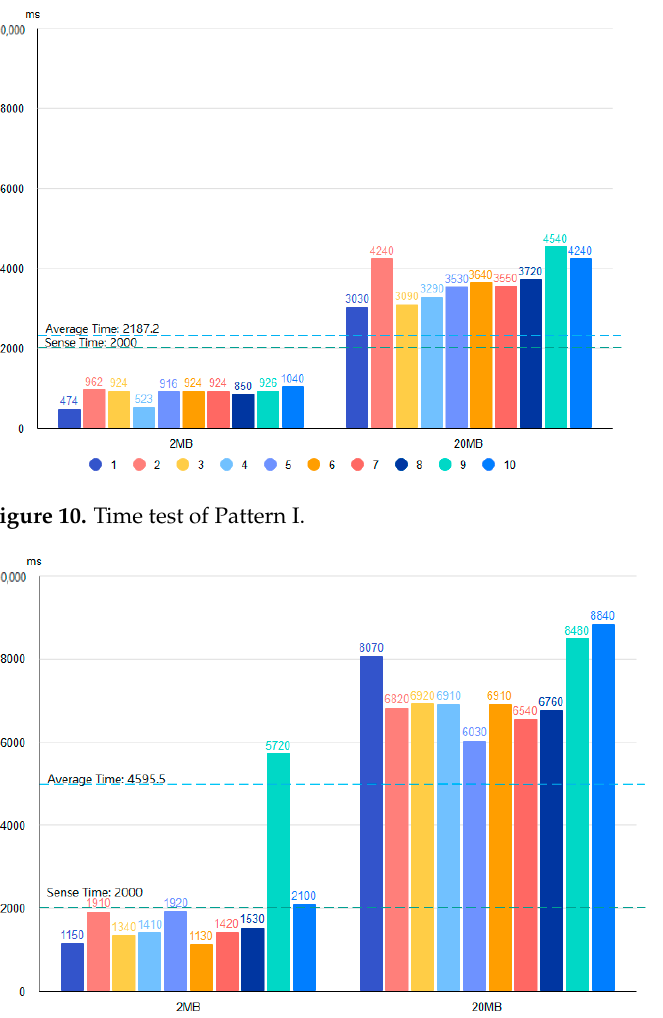
Figure 12. Time test of Pattern III.